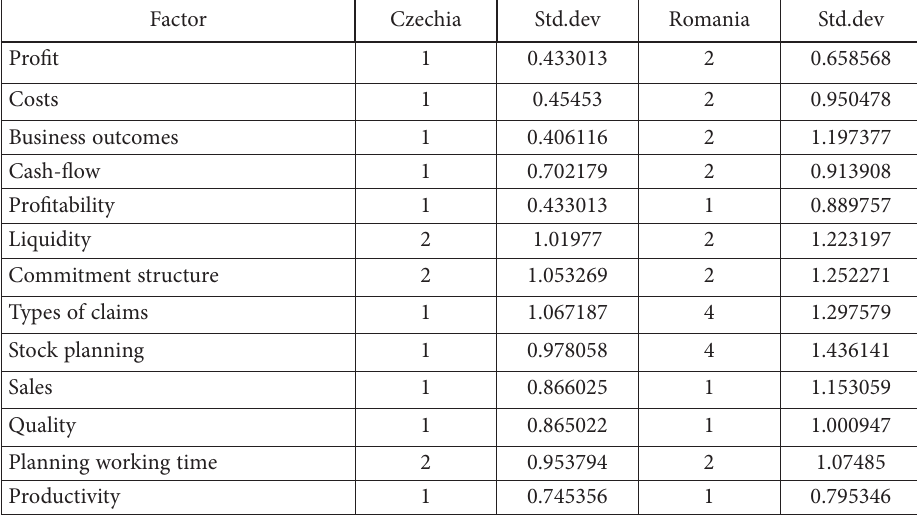
Table 6. Financial issues – A student view (survey data mode values, differences are in bold) Factor